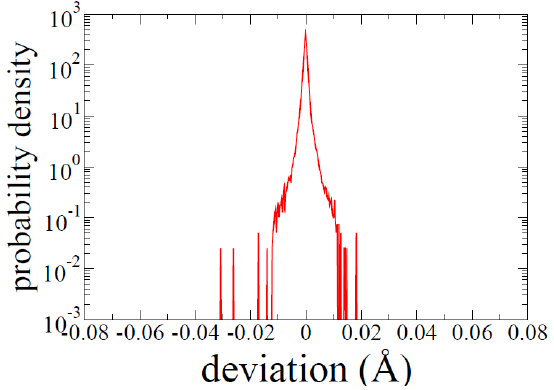
Figure 4. A typical distribution of the scalar “error variables” introduced in the text is shown. Here, for pathway generation, Δ = 8.063 fs, N = 75 atoms, and P = 300 are used. To obtain the distribution function, 3 N ( P − 1) = 67275 scalar “error variables” are used. is shown. Even with the relatively large time step of Δ = 8.063 fs, the size of the deviation is rather limited.